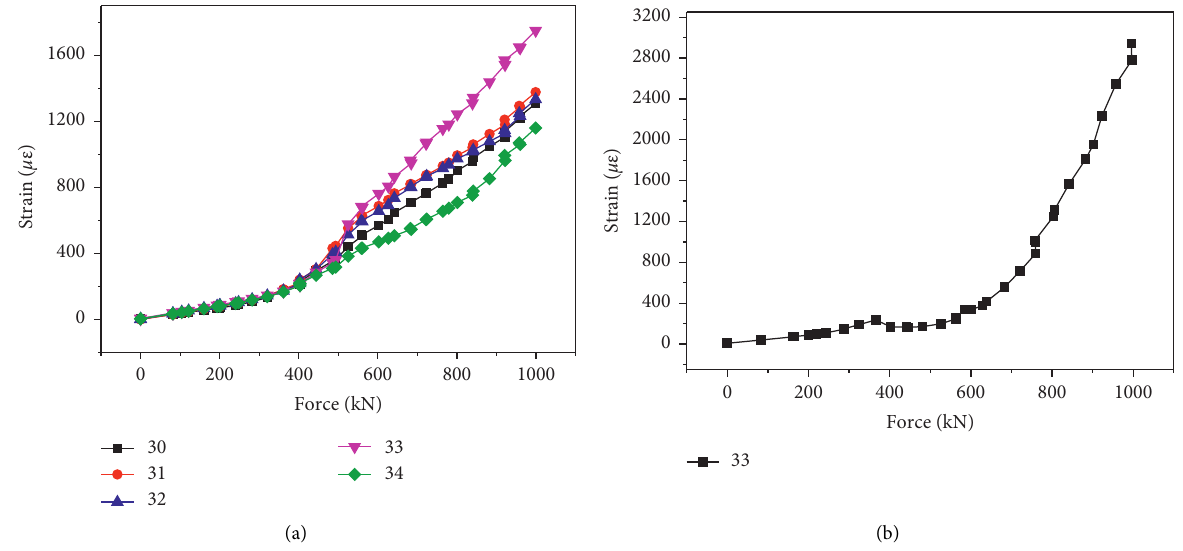
Figure 21: Load-strain curves of bottom steel plates of (a) SC-P1 and (b) SC-P2.